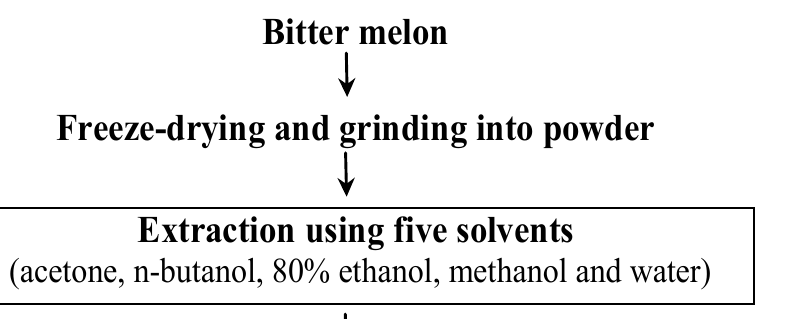
Figure 1. Diagram for the experimental design. Initially, the total phenolic content (TPC) and antioxidant capacity (AC) of the extracts of freeze-dried bitter melon powder obtained with five different solvents, including water, were compared. The aqueous extraction conditions were then optimised in terms of TPC and AC and compared to the 80% ethanol extract, which had the highest values in the initial solvent screening